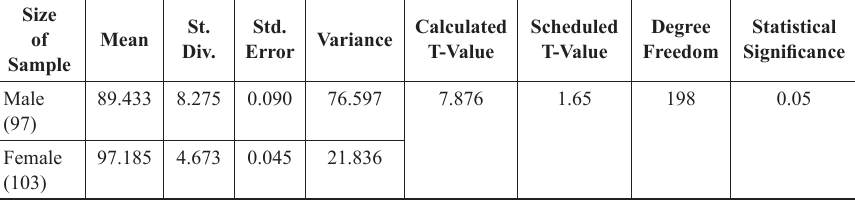
Table 3. The results of the T-test to measure the significance of the difference between the average real and hypothetical performance of the research sample